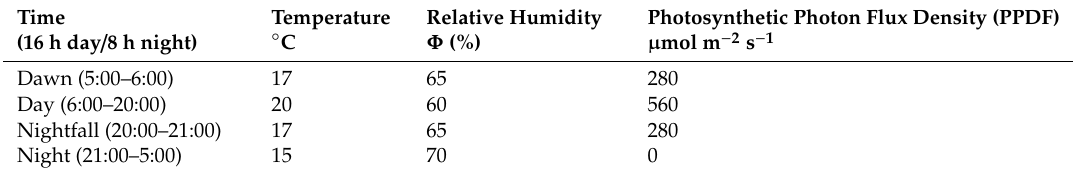
Figure 6. Scheme: activation of flowering within spring ( A ) and winter varieties without ( B ) or with vernalization ( C ) according to [5]. (SD—short day, LD—long day, GA in —native phytohormones, GA ex —applied GA 3 ). Table 2. Growing conditions in the air-conditioned